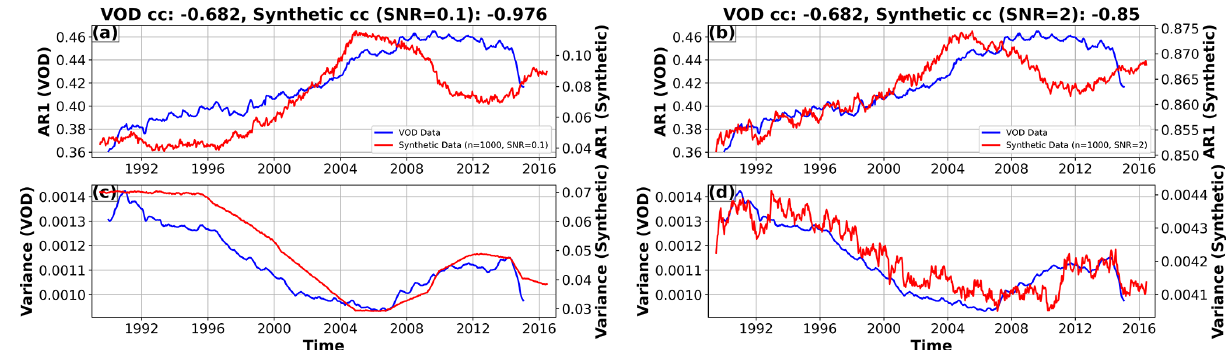
Figure 3. Comparison between real and synthetic data. (a, b) Median AR1 for synthetic data (red) and vegetation optical depth (VOD) data (blue; median taken over all AR1 series globally). (c, d) Same as (a, b) but for the variance. Panels (a) and (c) show low signal-to-noise ratio (SNR = 0.1); panels (b) and (d) show SNR = 2 for the synthetic data. AR1 and variance are calculated on a 5-year rolling window. Correlation coefficients (cc’s) between AR1 and variance are given in the individual panel titles. Both the synthetic and satellite data sets show negative correlation, modulated by SNR. Note that satellite and synthetic data are not plotted on identical y axes. The global medians of AR1 and variance time series for the VOD data can be approximated to some extent by the corresponding medians of AR1 and variance time series for the synthetic data, which suggests that the global medians of AR1 and variance are biased by changes in the VOD satellite composition through